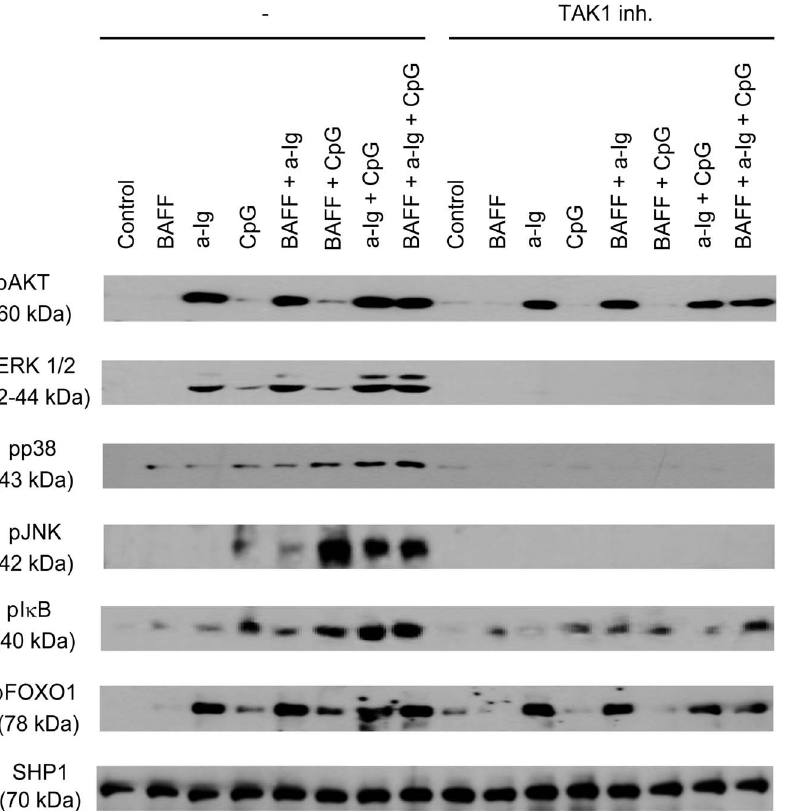
Figure 3. TAK1 dependent activation of the MAPK and NF k B pathways in B cells stimulated with combinations of anti-IgG, CPG ODN and BAFF. Resting tonsill B cells were stimulated with combinations of anti-Ig (2.5 m g/ml), BAFF (100 ng/ml) and CpG (2 m g/ml) for 30 min with or without TAK1 inhibitor ((5Z)-7-Oxozeaenol), and the phosphorylation of various signaling molecules was tested by Western blot.